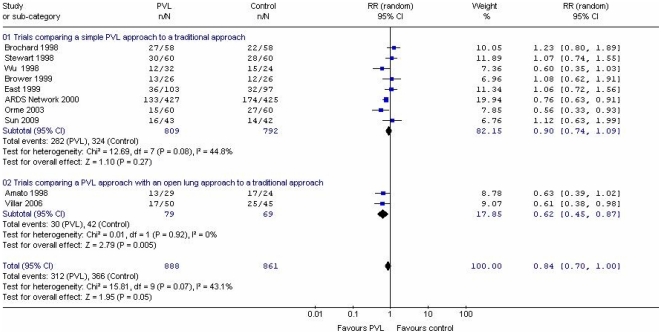
Forest Plot of Hospital Mortality.